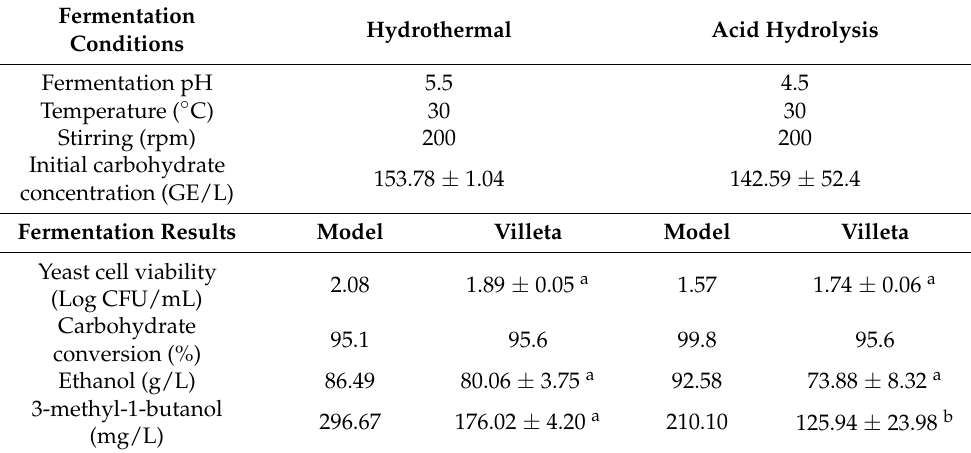
Table 7. Fermentation results during fermentation of sugarcane press-mud collected from Villeta . Fermentation